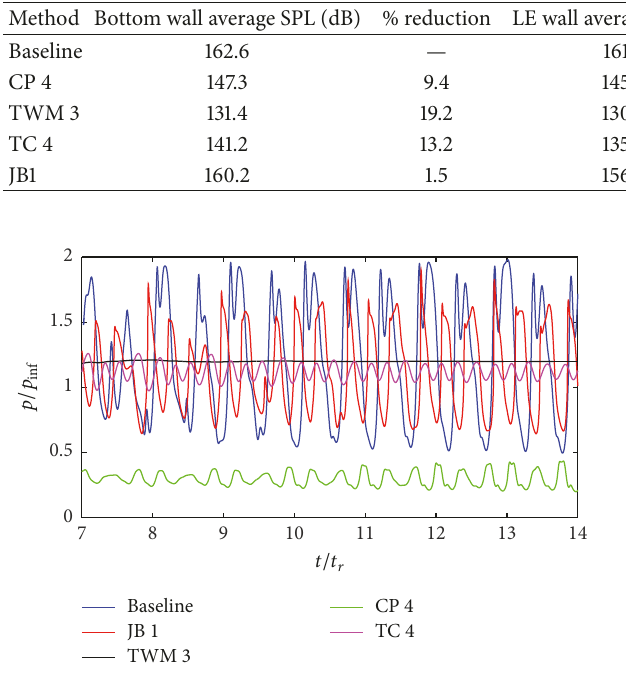
Figure 30: Pressure distribution comparison for the most effective control